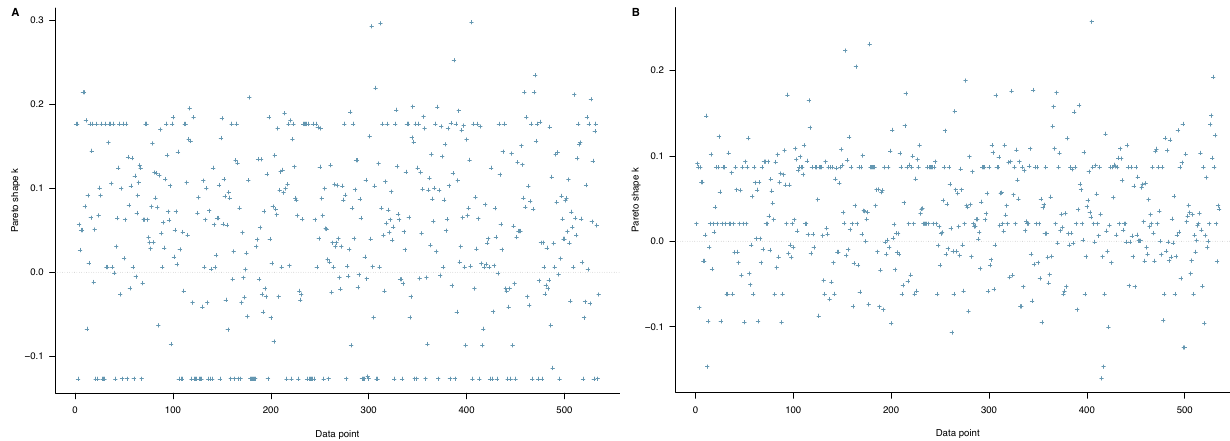
Fig. 9 PSIS-LOO diagnosis. PSIS-LOO diagnosis for A Model 3a and B Model 3b with priors as norm (1,0.5). The model ’ s goodness-of- fi t can be classi fi ed into four levels: (1) ‘ good ’ if its k -values are all below 0.5, (2) ‘ OK ’ if its k -values are more than 0.5 and below 0.7, (3) ‘ bad ’ if its k -values are more than 0.7 and below 1, and (4) ‘ very bad ’ if its k -values are more than